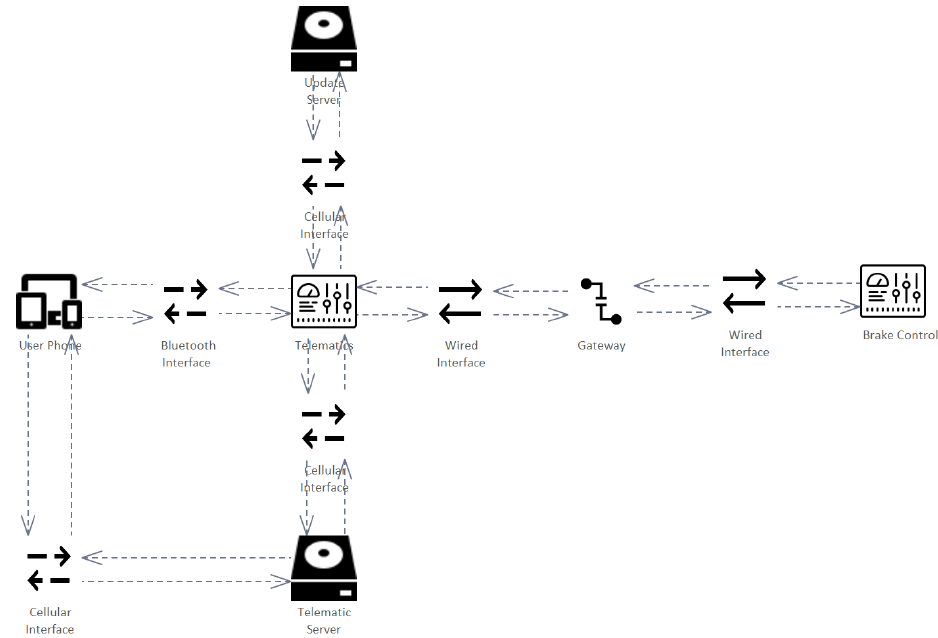
Figure 5. Example model to demonstrate attack flows.